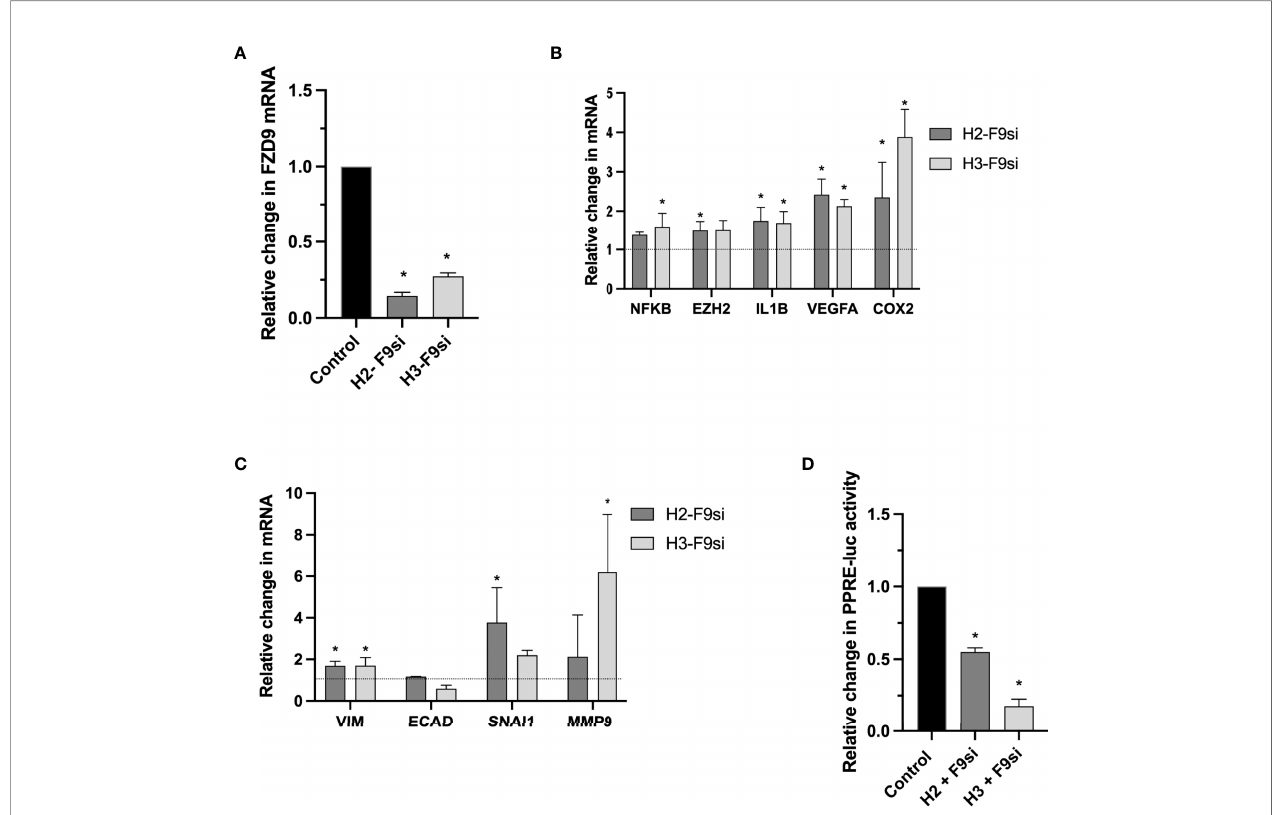
FIGURE 1 | Loss of FZD9 alters downstream targets in HBEC. siRNA was used to knock down FZD9 expression in HBEC3KT and HBEC2KT cell lines and results are shown relative to a scramble siRNA control. (A) FZD9 expression measured by qPCR. Results are normalized to GAPDH. (B) Gene expression with FZD9 siRNA transfection was measured for NFKB, EZH2, IL1B, VEGFA and COX2. Results are normalized to GAPDH and relative to a scramble siRNA control (dotted line). (C) Expression of VIM, ECAD, SNAI1 and MMP9 was measured after FZD9 siRNA transfection. Results are normalized to GAPDH and relative to a scramble siRNA control (dotted line). (D) Change in PPRE-luciferase activity. Each cell line is shown relative to its own control transfection (set to 1). Transfections and qPCR were conducted in triplicate. H2-F9si, HBEC2KT + FZD9 siRNA; H3-F9si, HBEC3KT + FZD9 siRNA. Statistical signi fi cance was measured by a two tailed t-test relative to each cell line ’ s control. Signi fi cance is *p<0.05 compared to